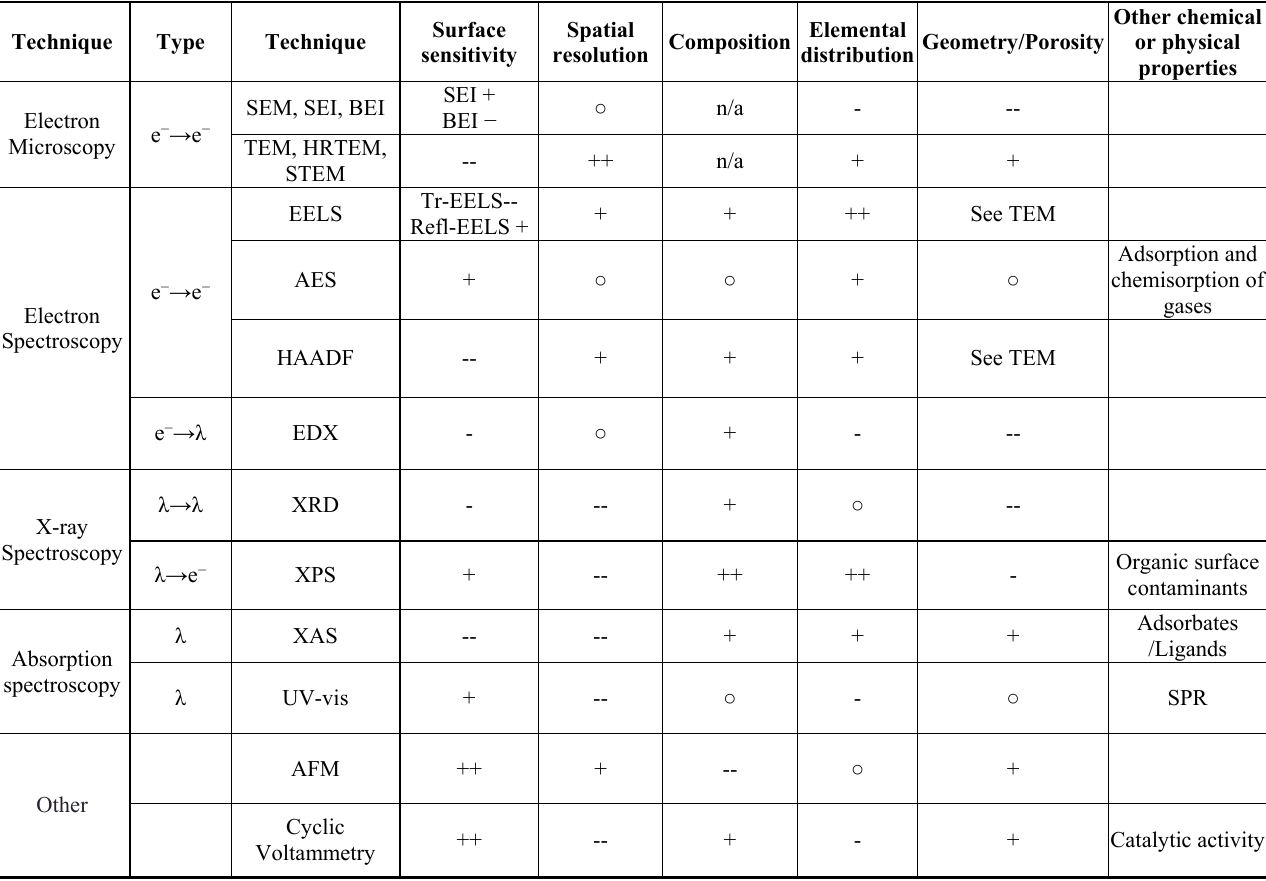
Table 2. Grading of characterization